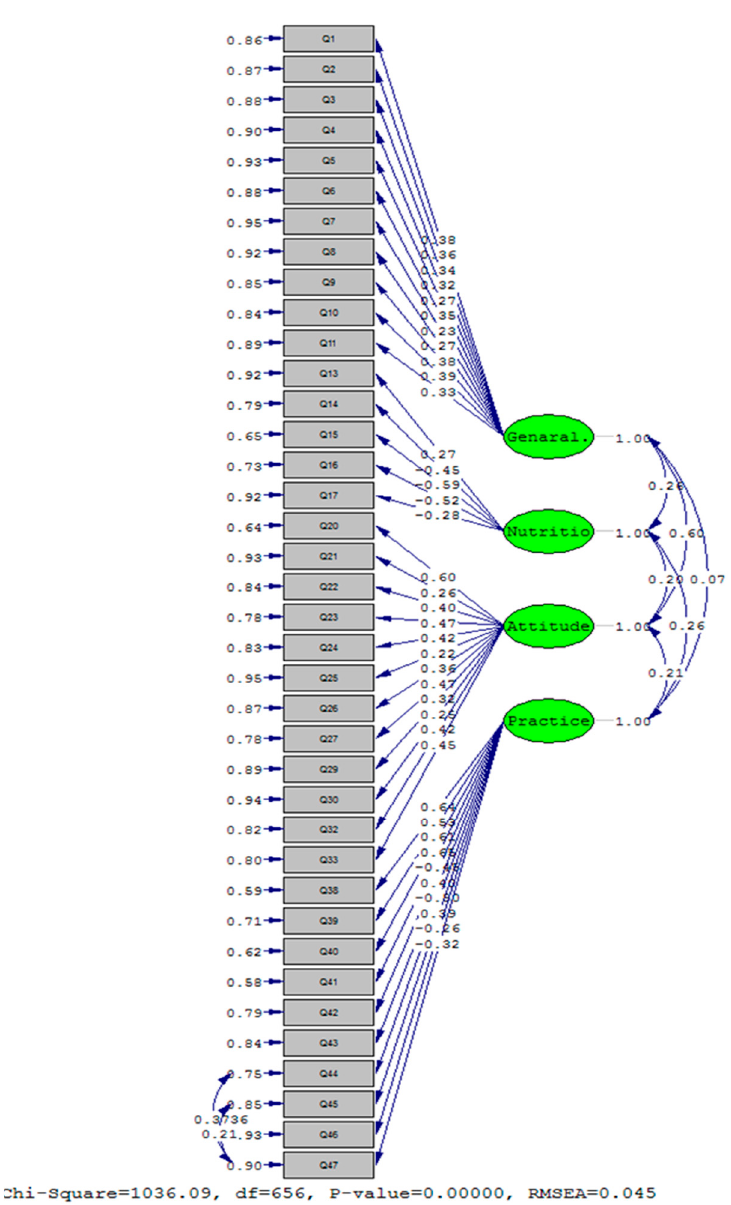
Figure 2. Standardized factor loadings of measurement model of D-KAP-38. Four latent constructs and 38 observed items were included in the confirmatory factor analysis (CFA) model. Based on the results of chi-square statistic and in order to achieve acceptable fit indices, the correlation of “q44, q47” = 0.37, “q45, q47” = 0.21, and “q45, q46” = − 0.36 have been added to model.